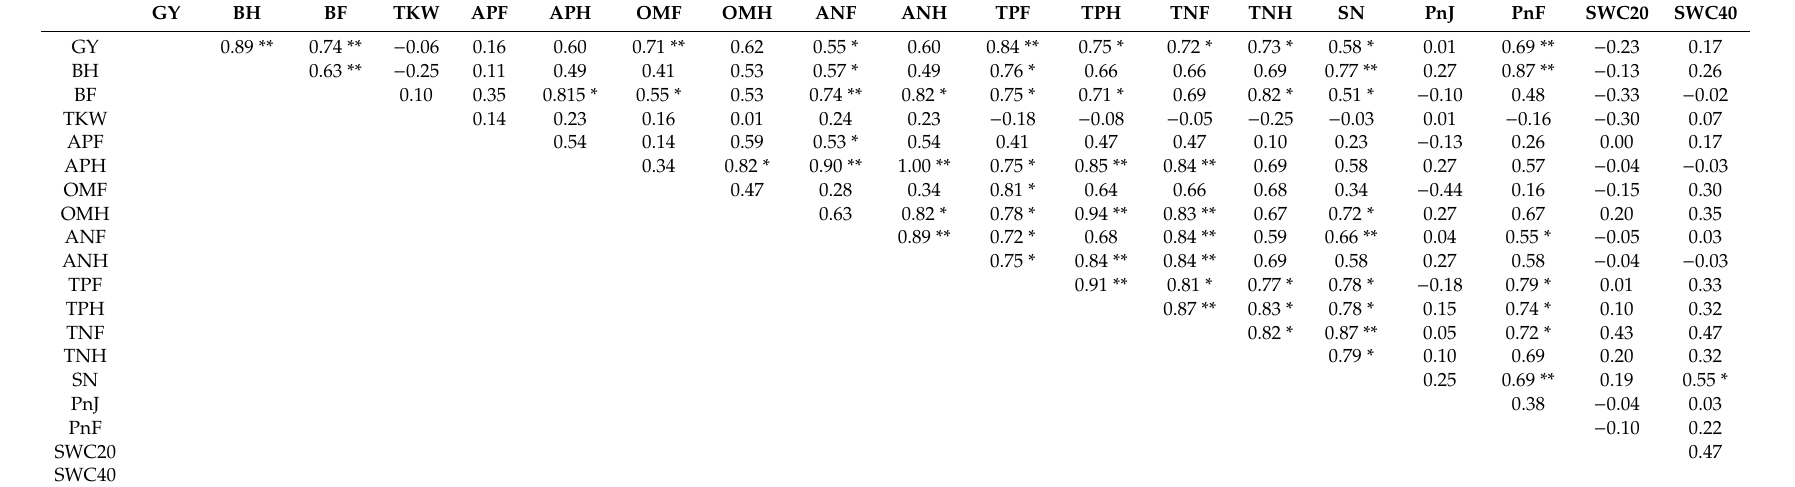
Table 7. Correlations between grain yield, biomass, soil properties, and